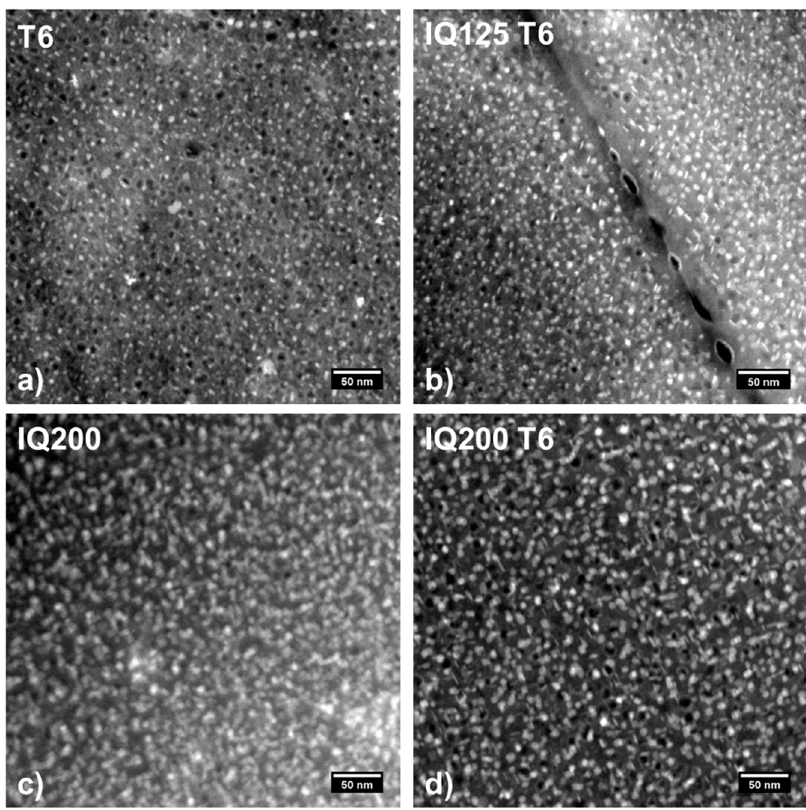
Figure 3. ( a – d ): Scanning transmission electron microscopy high-angle annular darkfield (STEM HAADF) images of hardening phases in the alloy AA7050 in a conventional T6 state a ) and after IQ125 T6 b ), IQ200 c ) and IQ200 T6 d ).